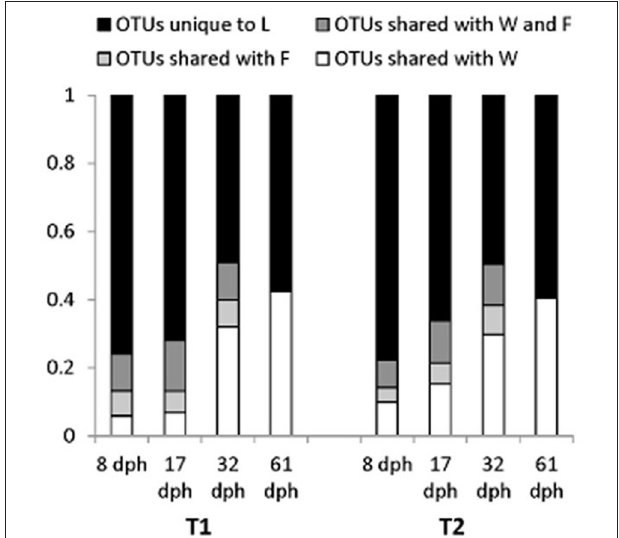
FIGURE 8 | Bar graph indicating the fraction of larval microbiota Operational taxonomic units (OTUs) shared with concurrent water samples and relevant live food samples at each sampling time for Tank 1 (T1; fed copepods) and Tank 2 (T2; fed rotifers). L, larvae; F, food; W, water. OTUtaxonomic units represented by only one read (“singletons”) in the total dataset were omitted from the analysis. From Bakke et al. (2015). Reproduced with permission from John Wiley and